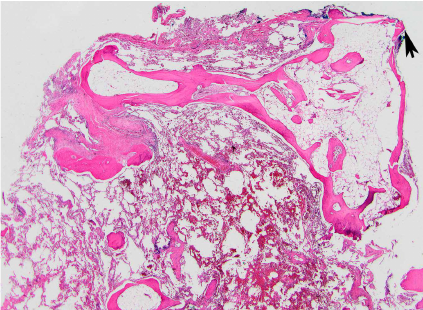
Figure 4: Focal areas of DPO in the subpleura with areas that appeared to extend through the pleura (arrow) (Hematoxylin and eosin; 40x).